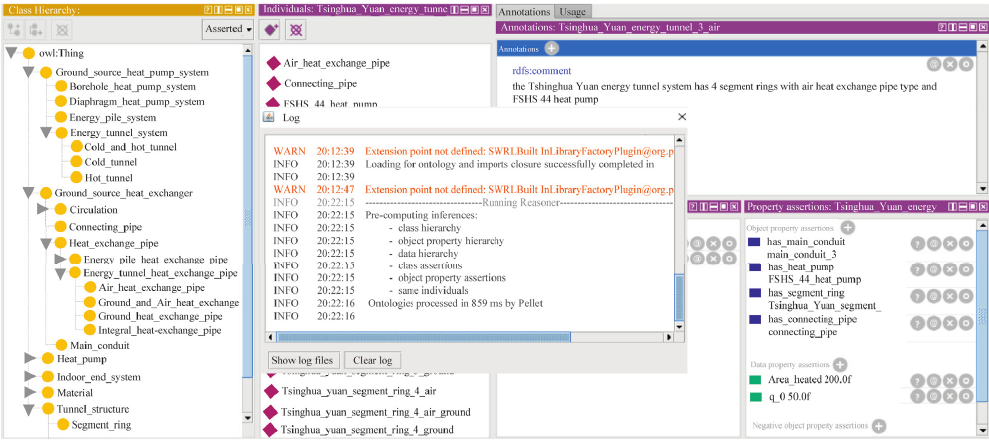
Figure 6: Log of execution pellet plugin to validate syntax of OntoETS.